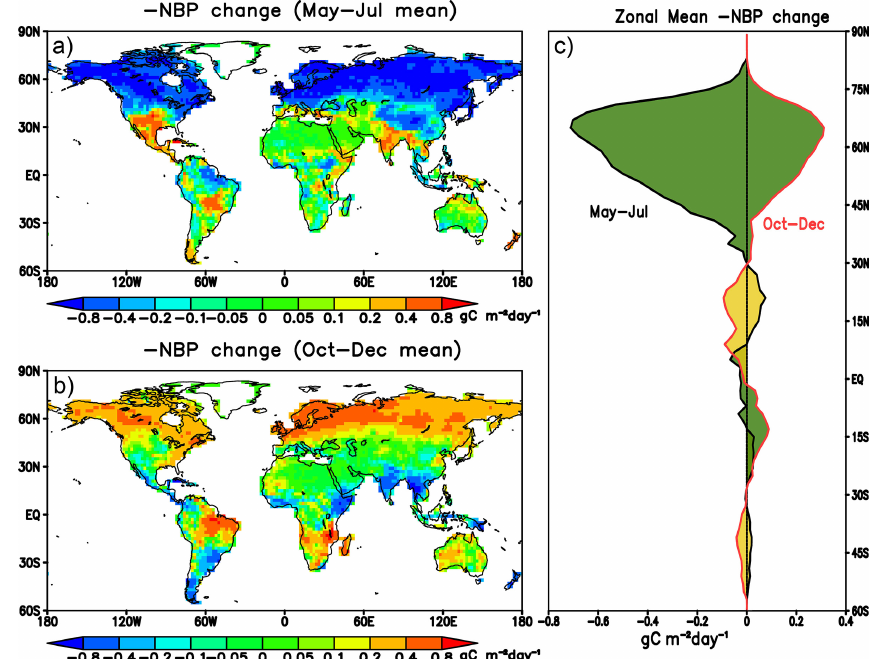
Figure 4. Spatial patterns and latitudinal distributions of 10-model mean − NBP (gCm − 2 day − 1 ) changes between 2081–2090 and 1961–1970, during mean (a) peak growing season (May–July) and (b) dormant season (October–December). (c) Aggregates the spatial patterns in (a) and (b) zonally, where the black curve corresponds to the − NBP changes in May–July (a) , and the red curve corresponds to the − NBP changes in October–December (b) . Further reduction of − NBP in peak growing season – where the black curve falls on the left of the zero line, and increase of − NBP in dormant season – where the red curve is on the right of the zero line, both contribute to amplitude increase. We shade those instances in green, and shade the reversed case (contribute negatively to global total − NBP amplitude increase) in yellow. It is clear that the amplitude increase is dominated by the boreal regions, and by changes in peak growing